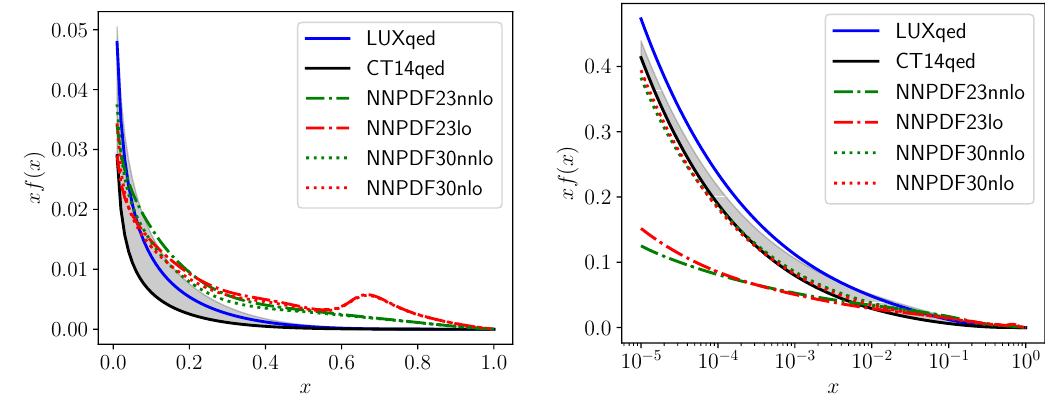
Figure 18 . 100 GeV, in linear (left) and logarithmic (right) scales.